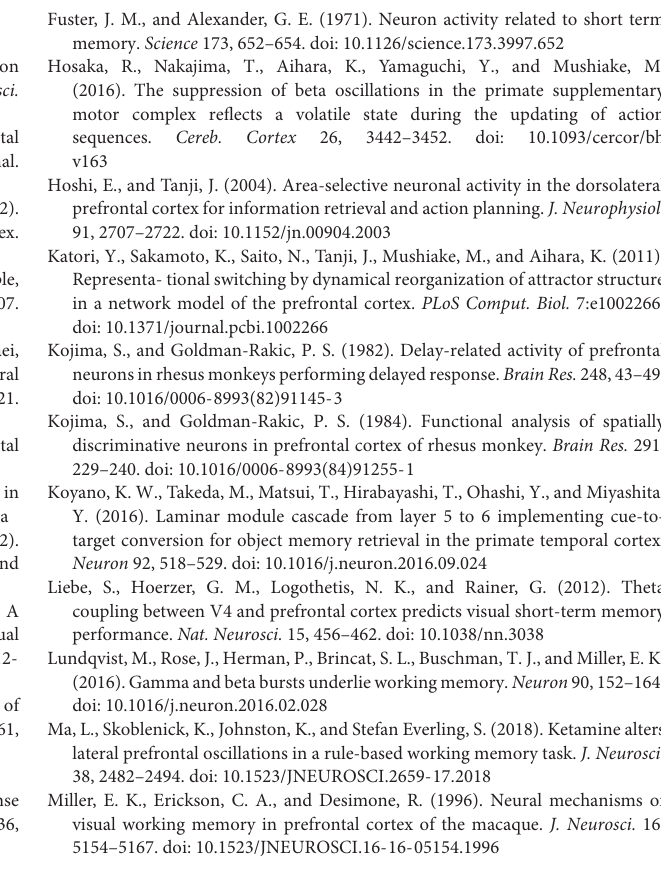
Supplementary Figure 4 | Distributions of STFM domains across the predictor variables analyzed in this study (A) and frequency ranges (B–D) . Relations to Figures 5B,C are also indicated. Supplementary Figure 5 | Comparisons between the influence of shape (A,B) and rule-related (C,D) factors on LFP modulations. Time-developments of the counts of STFMs is shown for the higher and lower gamma (A,C) , and theta and delta (B,D) ranges. (A) Formats are the same as in Figures 5D,E . A sliding window of 500 ms was used. + p < 0.005. Supplementary Figure 6 | The differential time-frequency spectra of the transformed shape in sample period (large – small) obtained from the channels along the multi-contact electrode inserted into a site in the convexity of the ventral LPFC of Monkey 1 (AP 34, DV –25). The spectra of ch.15, circled in yellow, are identical to those in Figure 3A and Supplementary Figure 2A . Supplementary Figure 7 | Spectra in the same format as Supplementary Figure 6 obtained from the electrode inserted into a site dorsal to the principal sulcus of Monkey 2 (AP 33, DV -19). Data from ch.15, circled in yellow, are included in the analysis. Note that although these spectra exhibited large changes compared to those in Supplementary Figure 6 , the lower channels showed spectra similar to that of ch.15, suggesting that the data from the lower channels were obtained from the ventral LPFC. Supplementary Figure 8 | Spatial distributions of STFM domains for Transformed Shape in Sample Rotation (A) , Shape-Specific Attributes Isosceles or Right Rectangle (B) , and Visual or Memory (C) . The scale of the balls in (A,B) of shape-related variables is proportional to that in Figure 5F , and that in rule-related (C) is proportional to that in Figure 5G